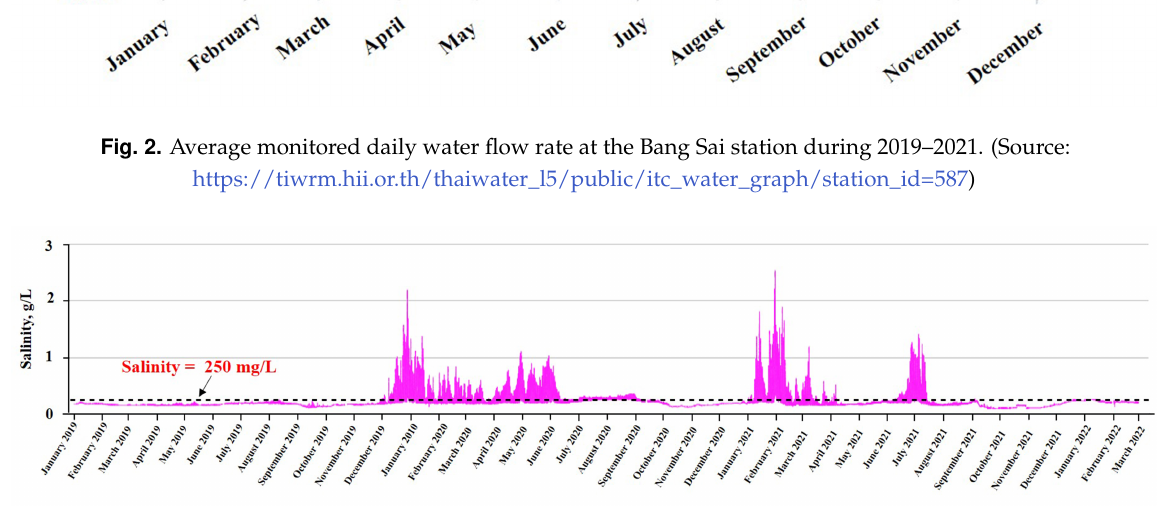
Fig. 3. Monitored salinity concentration in Chao Phraya River at Sam Lea pumping station from January 2019 to February 2022. (Source: